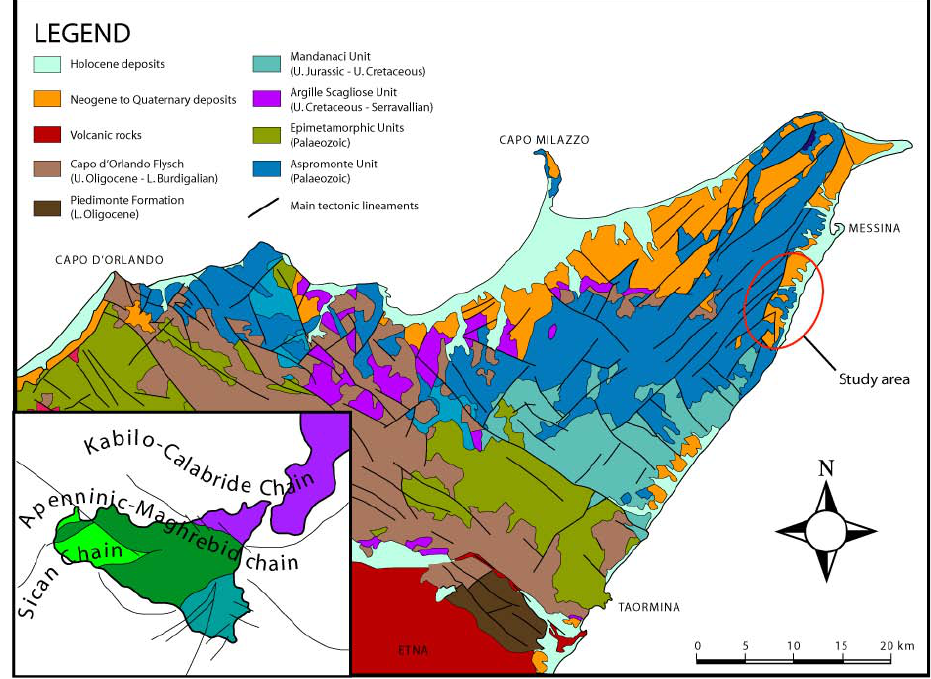
Fig. 1. Regional tectonic setting of the study area (redrawn from Lentini et al., 2000) with location of study